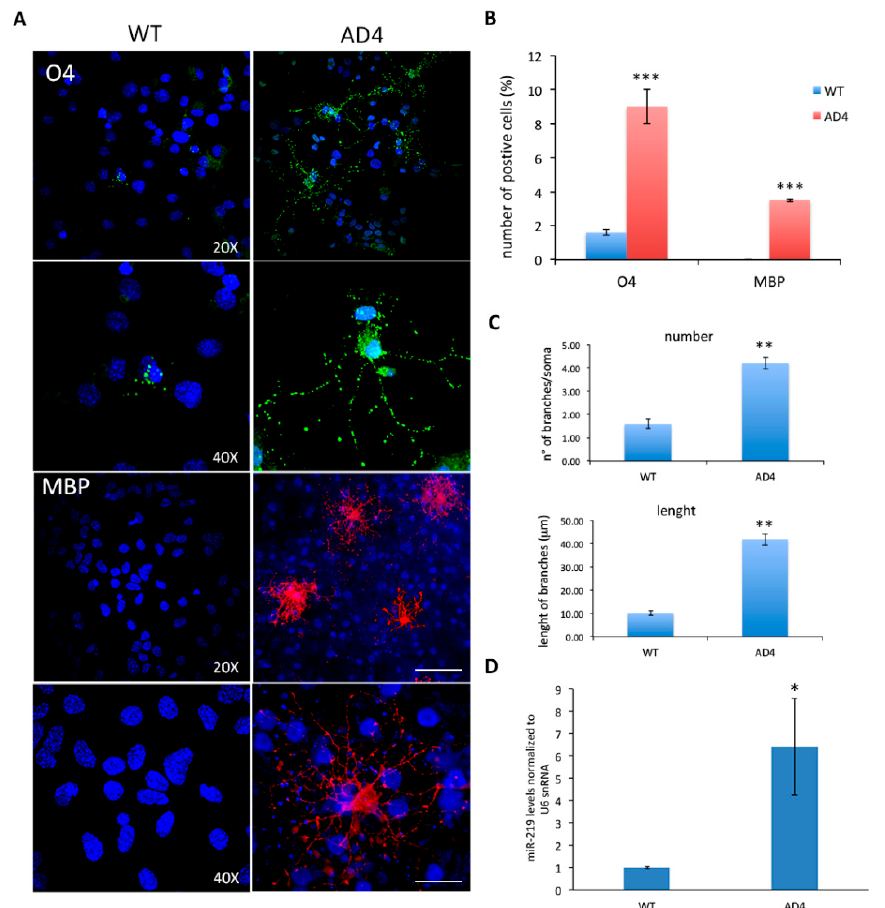
Figure 4. NGF neutralization promotes oligodendrogenesis in AD4 adult hippocampal progenitors. ( A ): Immunostaining for O4 (green) and MBP (red) in AD4 and in wild type (WT) neurosphere cultures upon oligodendrocyte (OL) differentiation. ( B ): Quantification of O4+ cells as in A (a total of 592 AD4 cells and 924 WT cells were examined). ( C ): AD4-derived OLs are more differentiated, in terms of number and length of branches and in terms of MBP expression, when compared to WT-OLs, as quantified in the histograms. Nuclei labeled with DAPI are in blue. Scale bars, 50 and 10 µ m, magnification 20 × and 40 × , respectively. ( n = 20). ( D ): Up-regulation of miR-219 in AD4 neurospheres by qRT-PCR from four independent experiments ( n = 4). The results are expressed as the mean ± standard error (SEM). Fold change and Statistical significance are calculated relative to the WT sample. Student’s t -test: * p < 0.05, ** p < 0.01, *** p <